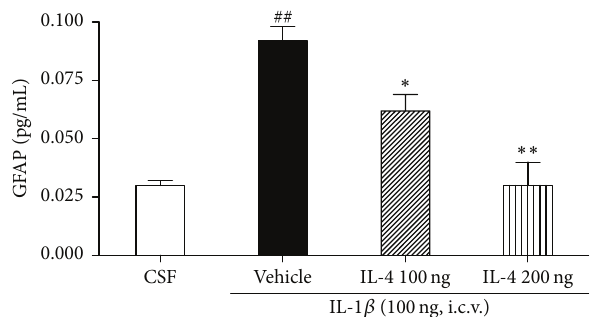
Figure5:EffectofIL-4injection2hoursafterinjectionofi.c.v.IL-1